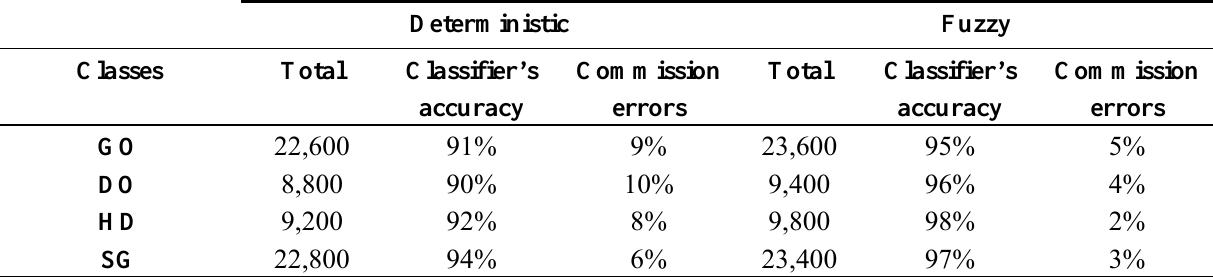
Table 3. Classifier’s accuracy and categories’ accuracy (commission